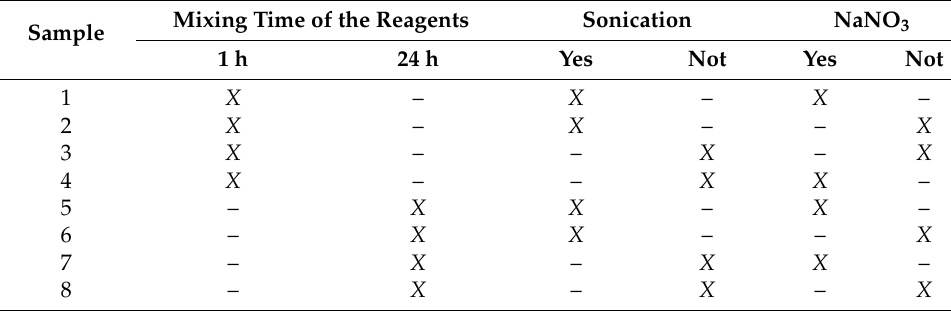
Table 1. Conditions for the graphite oxidation